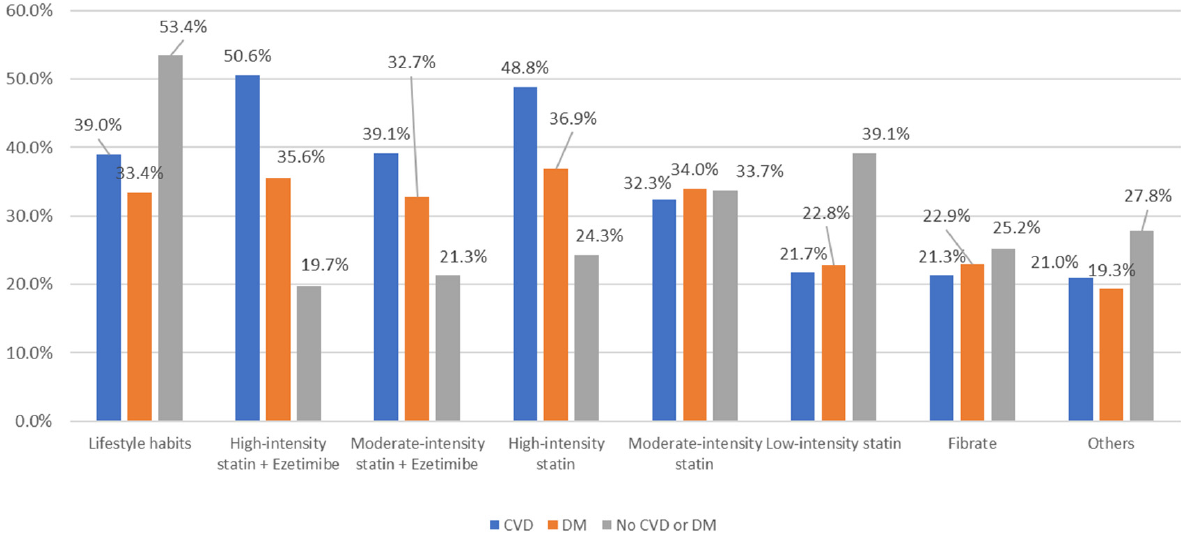
Figure 3. Treatment used by the physicians in patients with cardiovascular disease (CVD) and diabetes mellitus (DM), and in patients without any of these diseases. CVD: cardiovascular disease; DM: diabetes mellitus.